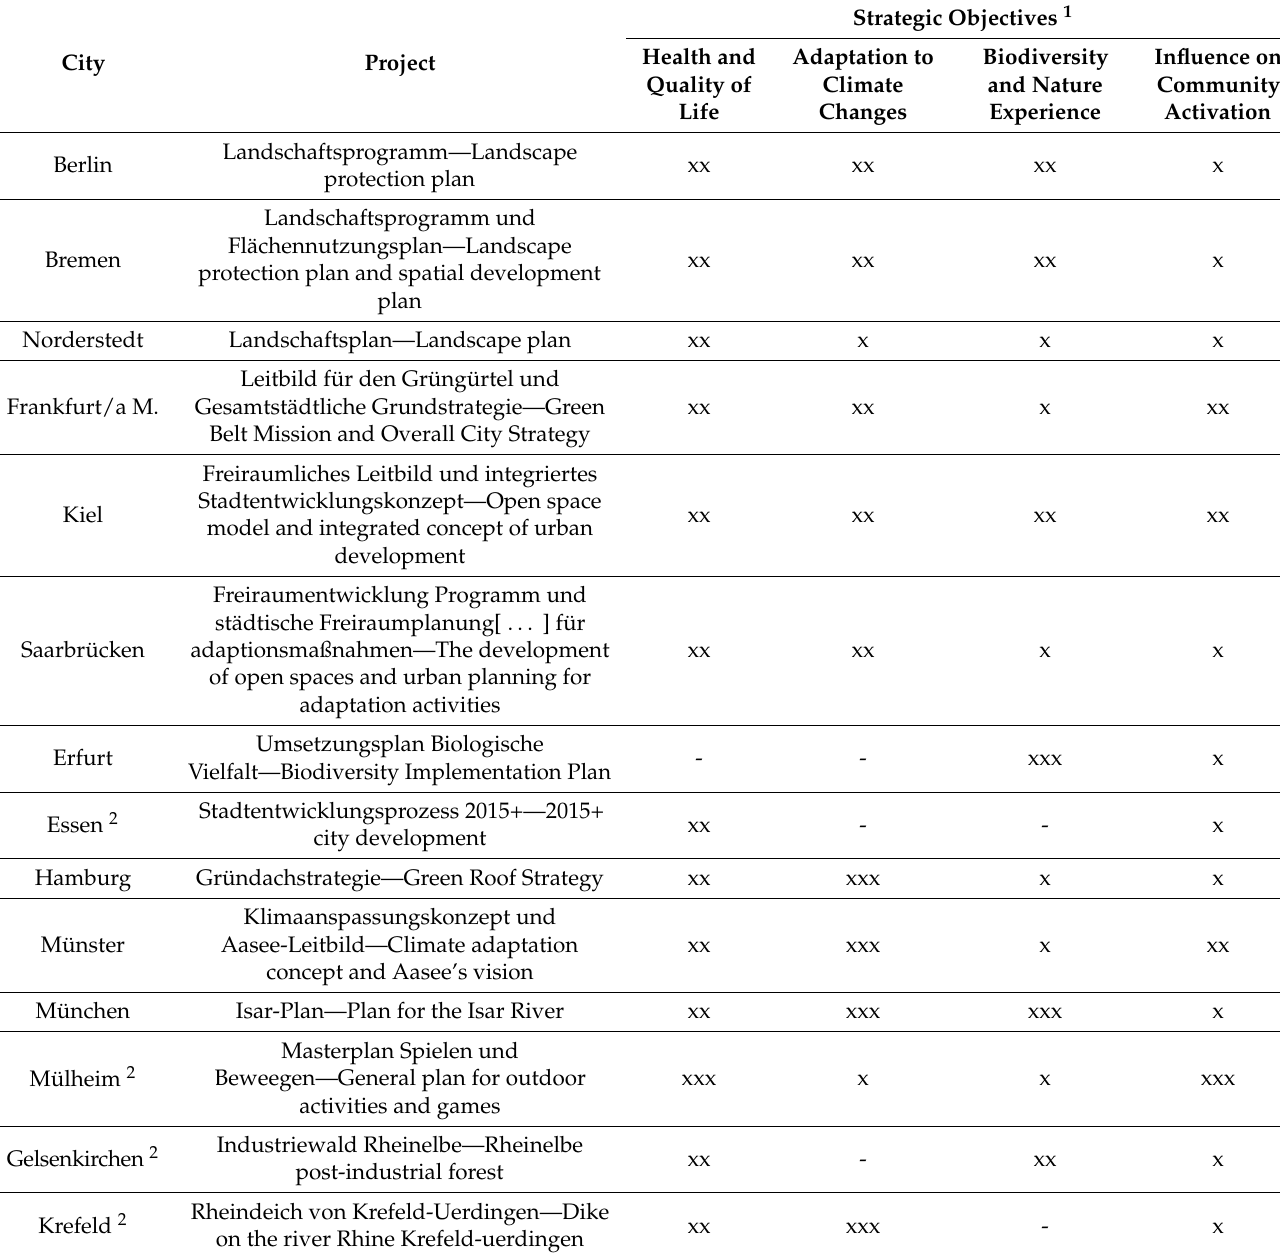
Table 8. Development strategy based on the example of selected cities. Source: www.bfn.de/fileadmin/BfN/service/ Dokumente/skripten/Skript503.pdf (accessed on 23 May